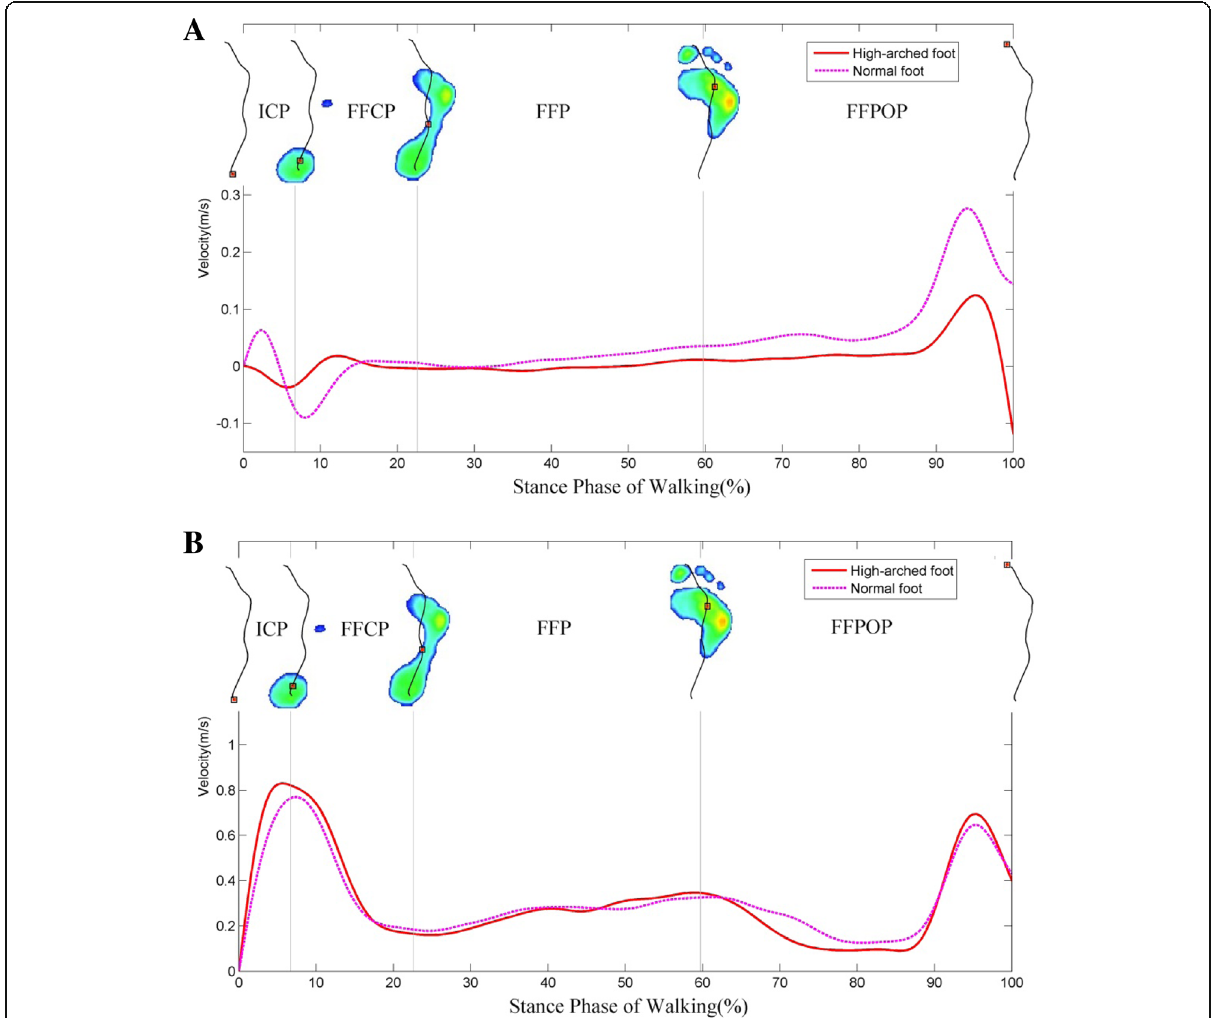
Fig. 3 The velocity of COP in medial-lateral ( a ) and anterior-posterior ( b ) direction for the high-arched and the normal-arched feet. The y-axis is the longitudinal axis of the foot, and x-axis is perpendicular to the longitudinal foot axis. Sub-classified phases are ICP, FFCP, FFP and